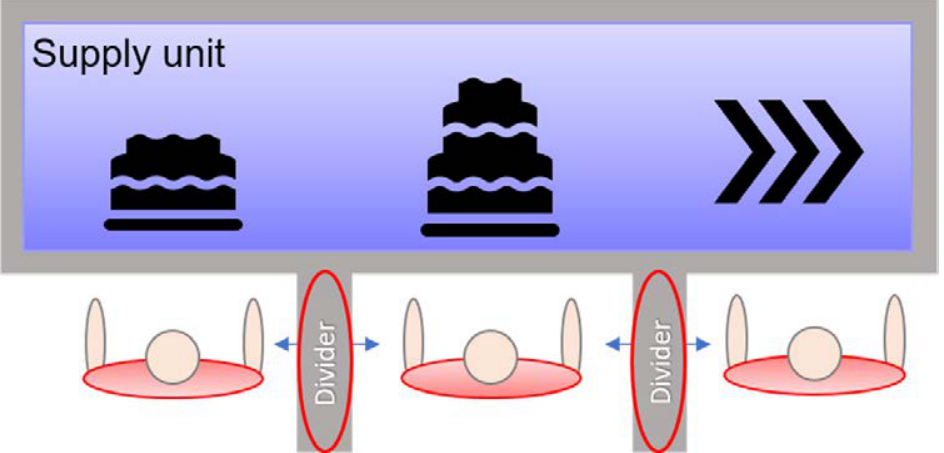
Fig. 1. The top view of a functional assembly line in the food processing industry and installation of dividers/barriers due to Covid-19 for single side engagement of